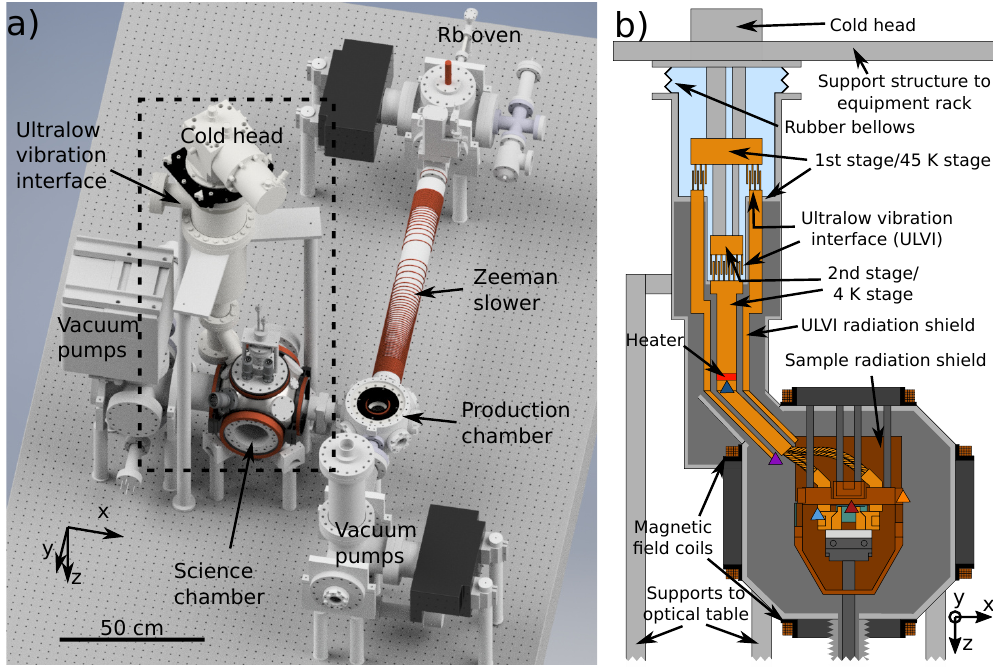
Figure 1: Schematic of the SQCRAMscope. (a) Rendering of the SQCRAMscope as mounted on the optical table. An equipment rack suspended from the ceiling (not shown) secures the cold head above the optical table. (b) Cross-section schematic of the inside of the science chamber (not to scale); region corresponds to the dashed black box in panel (a). Five temperature sensors are labeled by colored triangles: silicon diodes on the ULVI second stage (dark blue), ULVI radiation shield (purple), and sample mount (light blue), and a calibrated silicon diode on the sample chip (red) as well as a platinum sensor on the radiation shield